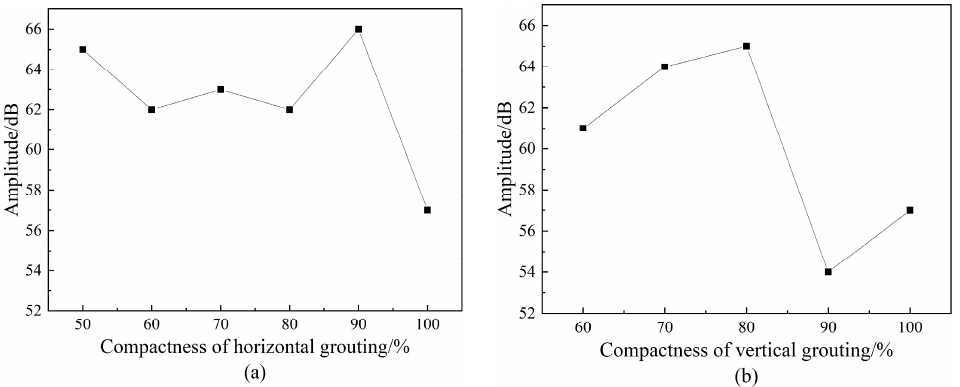
Figure 6. Amplitude of acoustic emission signals with different grout saturation.